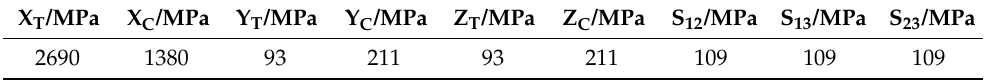
Table 2. Strength properties of T800S/3900-2B lamina.